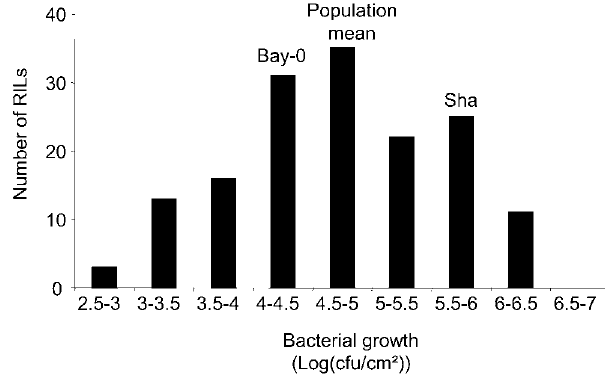
Figure 2. Distribution of bacterial growth values in the Bay-0 6 Shahdara recombinant inbred line (RIL) population. The frequency histogram shows the range of in planta bacterial populations observed in RILs three days post inoculation with Pseudomonas syringae pv. tomato DC3000 in one of the greenhouse experiments. The values obtained for the parental accessions, Bay-0 and Shahdara (Sha), and the genetic mean of the population are indicated.